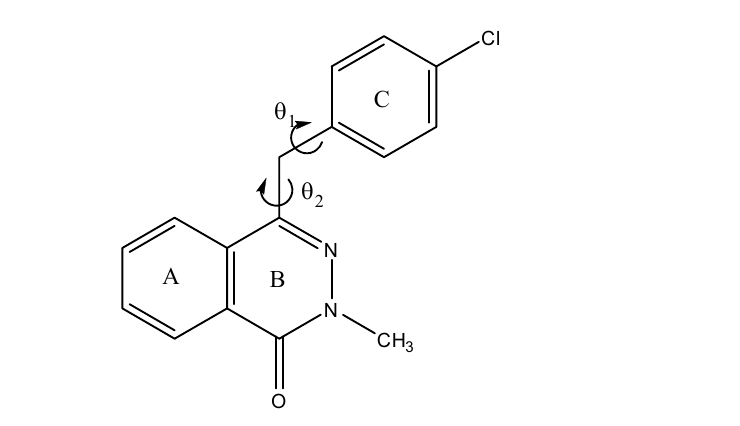
Figure 1. Phthalazinone 5 with definition of rings and main torsional